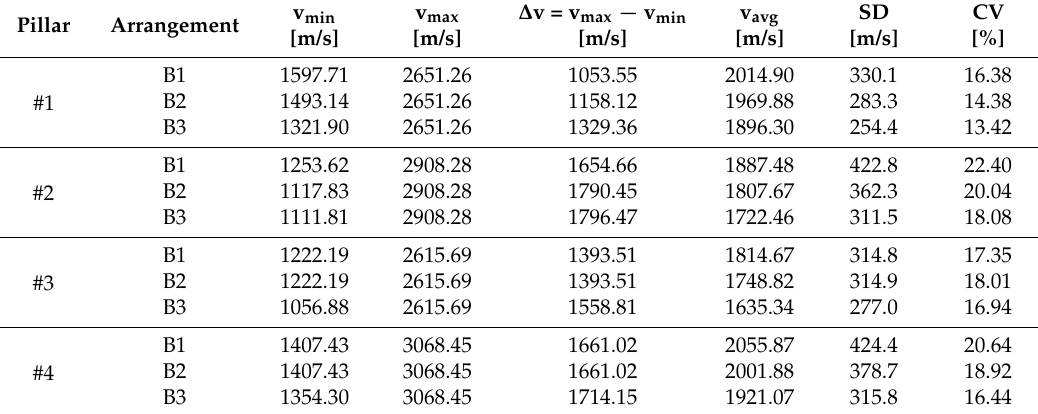
Table 6. Experimental wave propagation velocities for configuration #B.